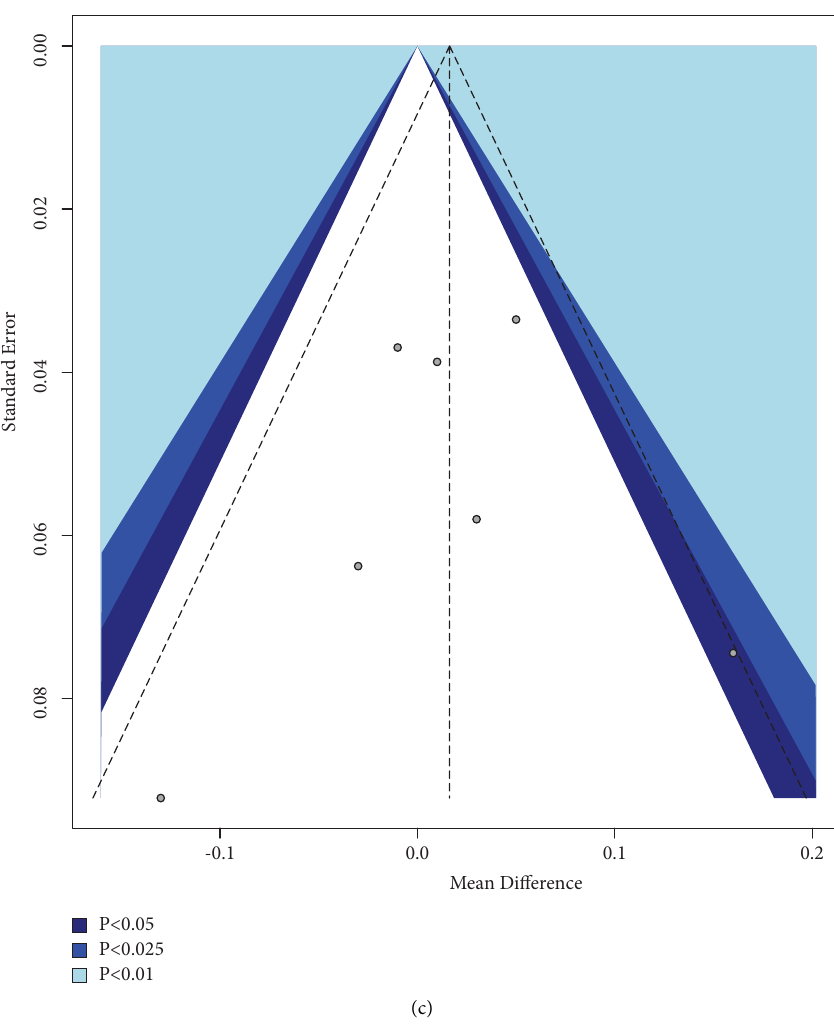
Figure 3: Contour-enhanced funnel plots visualizing publication bias. (a) GI outcome; (b) PI outcome; (c) OHI-S outcome. Te vertical dashed line in the middle of the funnel shows the average efect size.